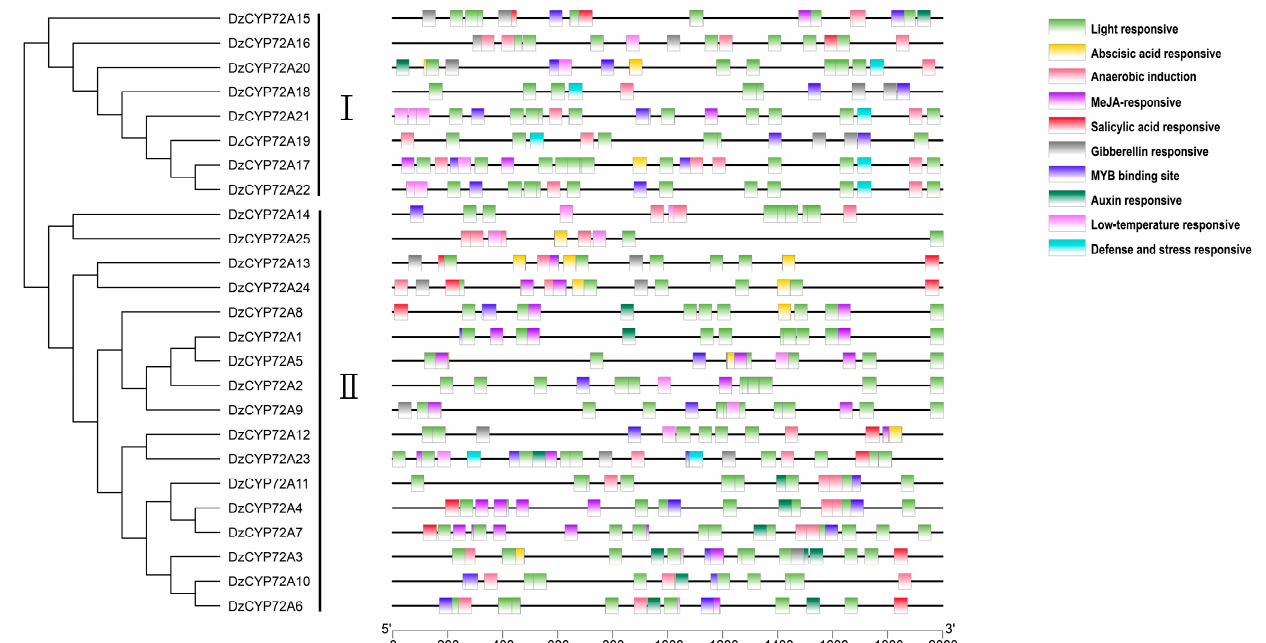
Figure 5. Predicted cis -regulatory elements in promoter regions of DzCYPP72As .